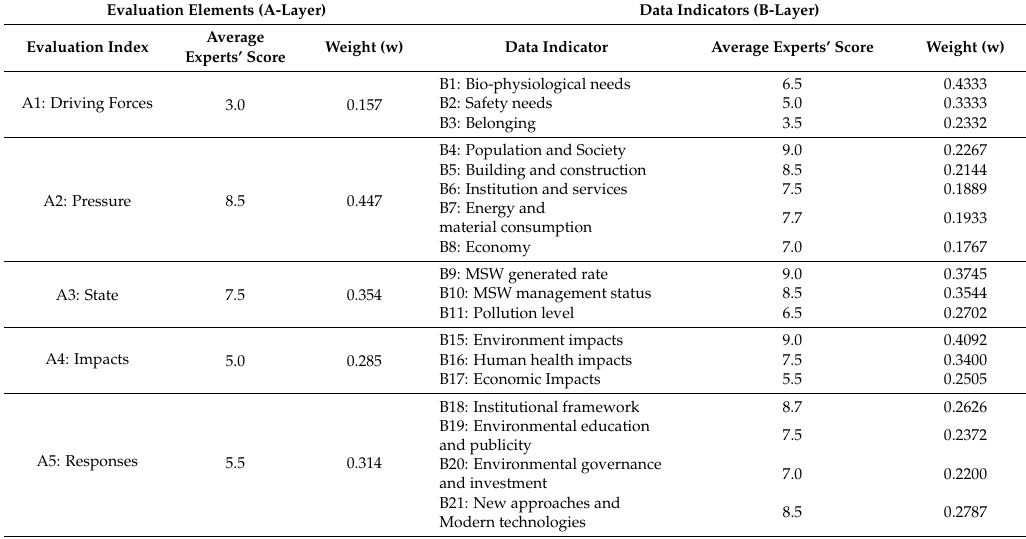
Table 4. Weights for ERI for Dar es Salaam